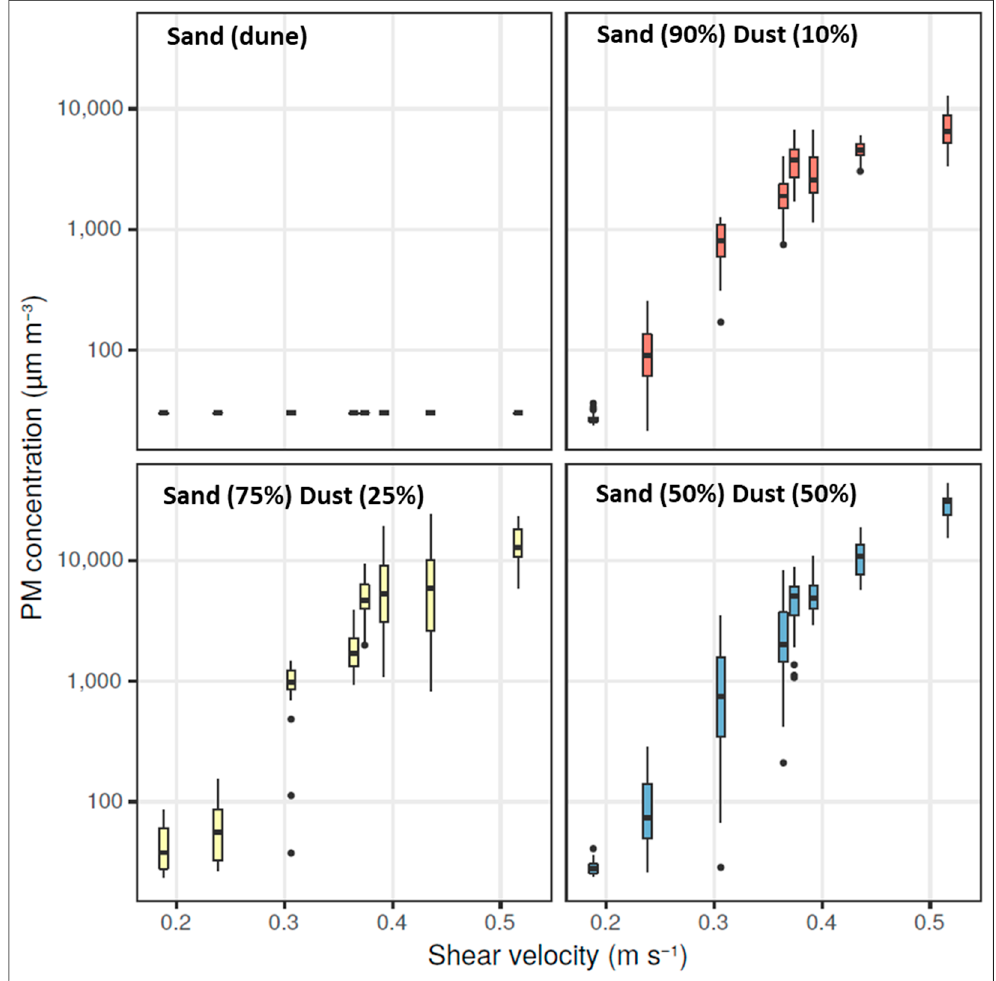
Figure 3. Particulate matter (PM) concentrations measured in the wind tunnel as a result of dust emission from the reference samples under various shear velocities. The reference soils are presented by the weight ratio of clay and silt and sand 10%, 25%, and 50%. No dust concentration was recorded for the sand (dune) sample. The average concentration is presented by the solid line inside the minimum-maximum box, and standard deviations are in bar lines. Note that the black dots represent extreme values.